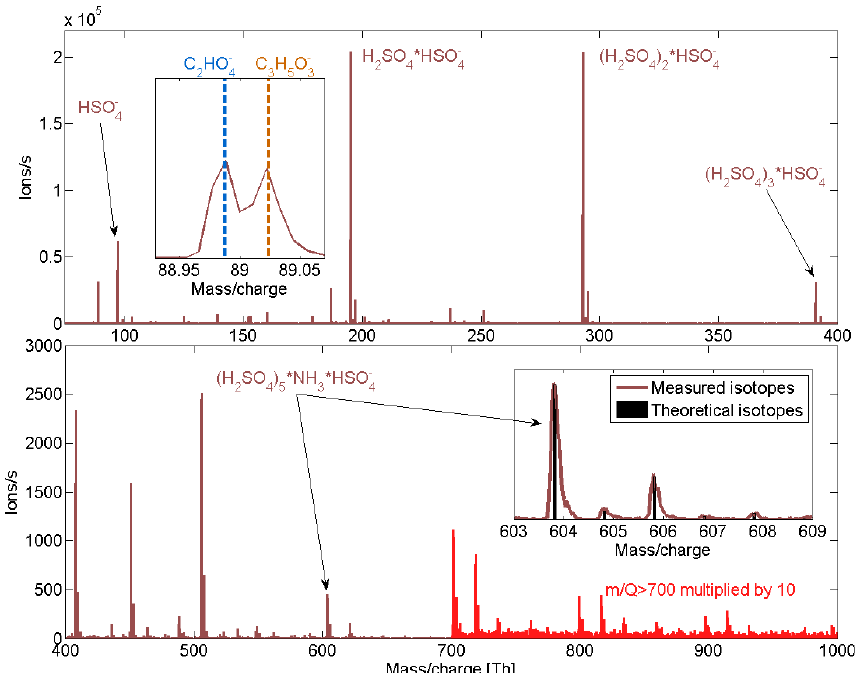
Fig. 8. Sulphuric acid was nebulized with a microchip and mixed with laboratory air before passing through a beta charger. The dominant peaks in the m/Q range below 400Th (upper panel) are sulphuric acid monomer-tetramer, followed by a peak at integer m/Q 89Th which is most likely a mix of oxalic and lactic acid, as seen in the inset plot. The m/Q range above 400Th is dominated by (H 2 SO 4 ) m (NH 3 ) n HSO − clusters. The identification was made based on the exact m/Q , and verified by the matching isotopic distributions, as can be seen in the inset showing the measured and theoretical isotopes of six H 2 SO 4 with NH 3 .